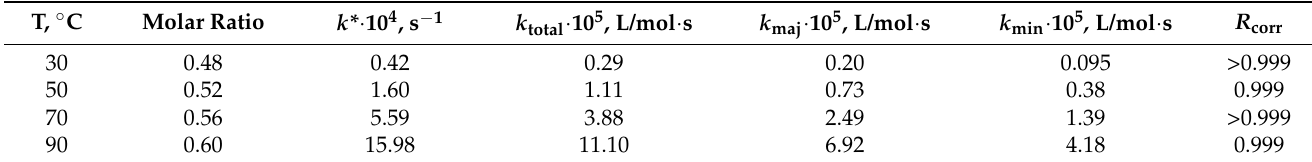
Table 1. Kinetic parameters for the reaction of 1h with pyrrole.